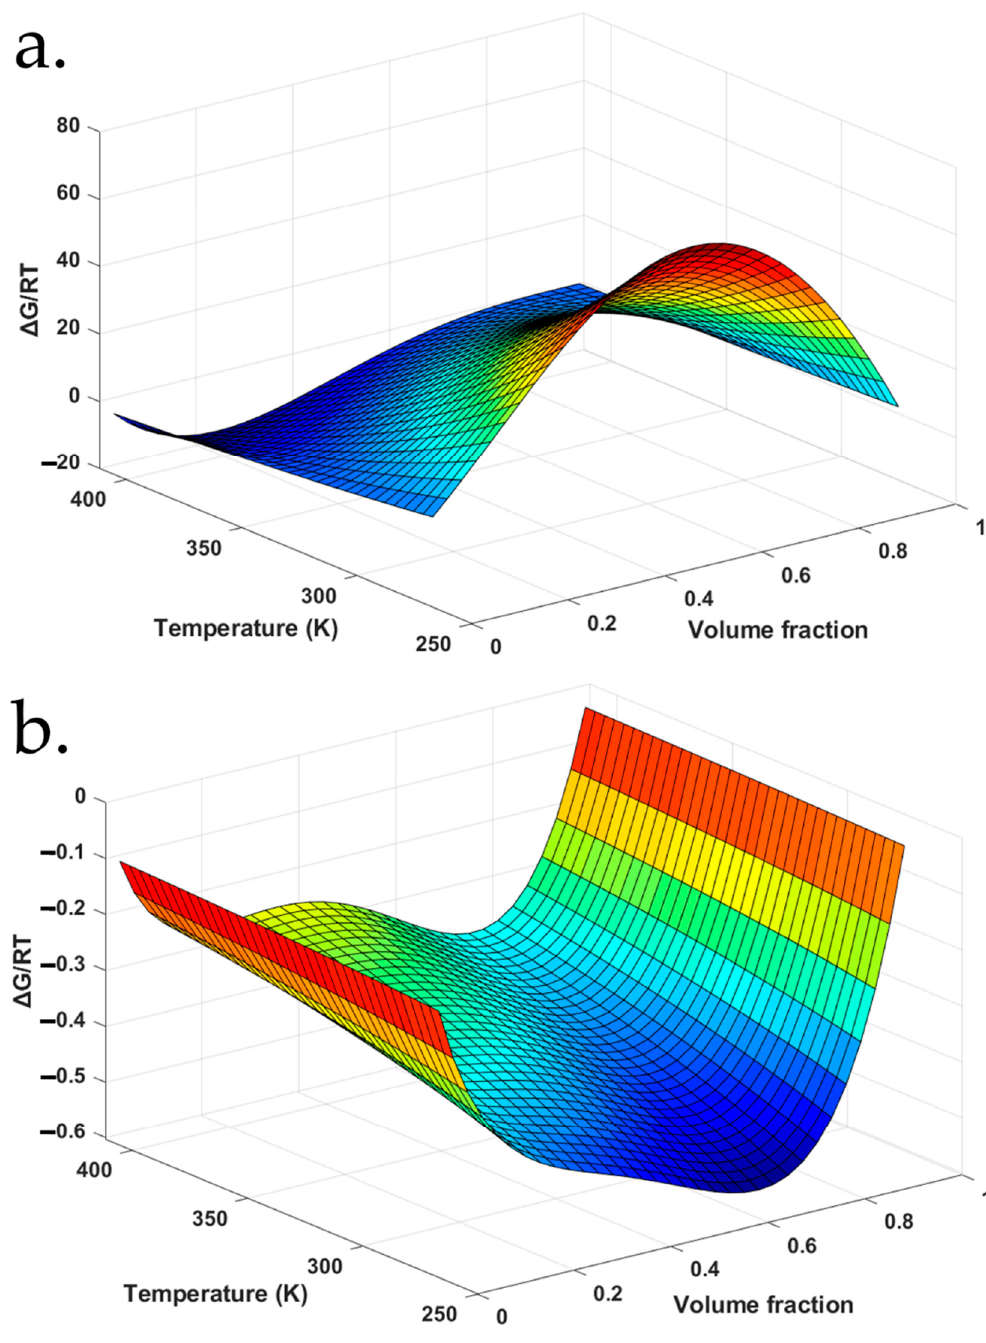
Figure 9. The Gibbs free energy surface for values ( a ) derived from dissolution / melting depression data and ( b ) both dissolution / melting depression and AAPS methods at various temperatures and composition volume fractions.